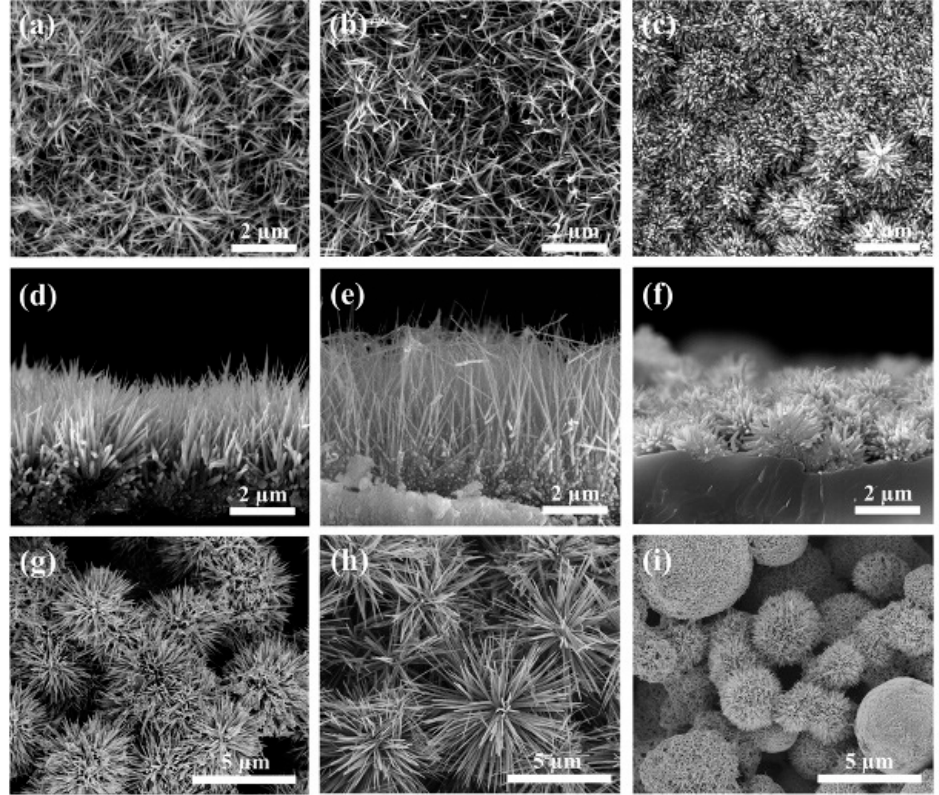
Figure 8. Catalytic CO oxidation performance of Pt loaded on ZnO nano ‐ arrays with different lengths and shapes. ( a ) CO oxidation conversion as a function of temperature over 1 μ m and 5 μ m long Pt ‐ loaded ZnO nanorod array and washcoated Pt/ZnO powder catalysts. ( b ) CO oxidation conversion as a function of temperature over Pt ‐ ZnO nanorod array and Pt ‐ ZnO nanoplate array. Reprinted with permission from [36], Copyright Elsevier,